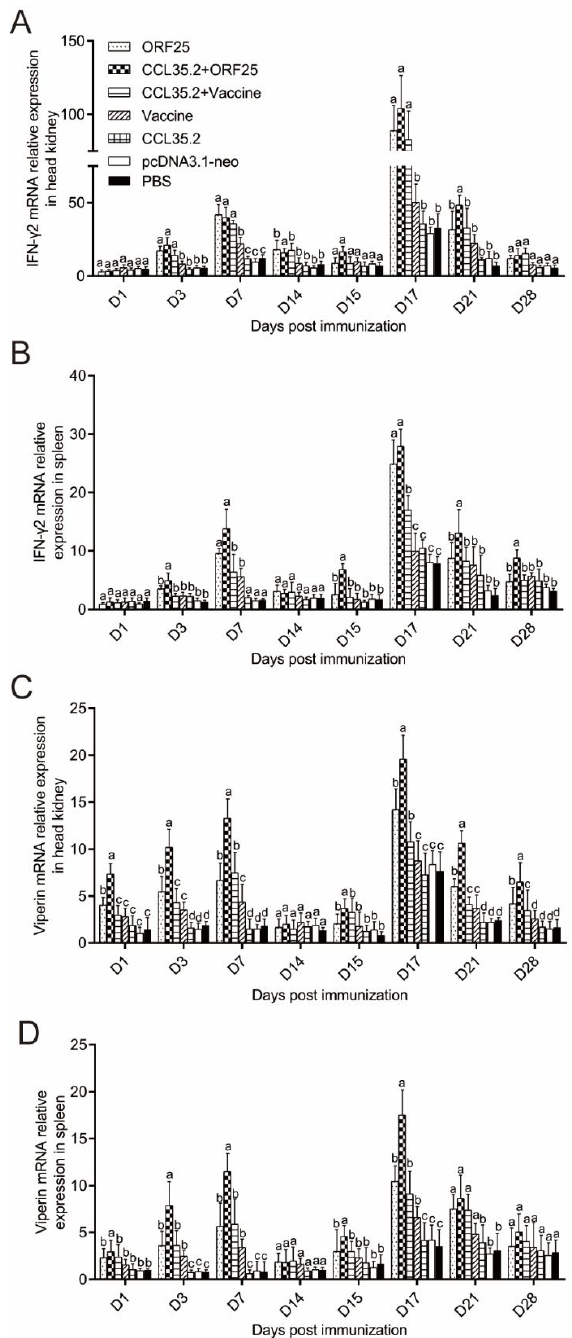
Figure 8. mRNA expression patterns of representative important immune regulation and effector genes in head kidney and spleen tissues. IFN-γ2 ( A , B ) and viperin ( C , D ) transcripts were examined by qRT-PCR. β-actin gene was used as an internal control gene. Different superscript letters in each group (a–d) denote significant variations suggested by the Kruskal–Wallis statistics at 95% of significance, followed by the Dunn test with Bonferroni adjustment as the post hoc test ( p < 0.05).